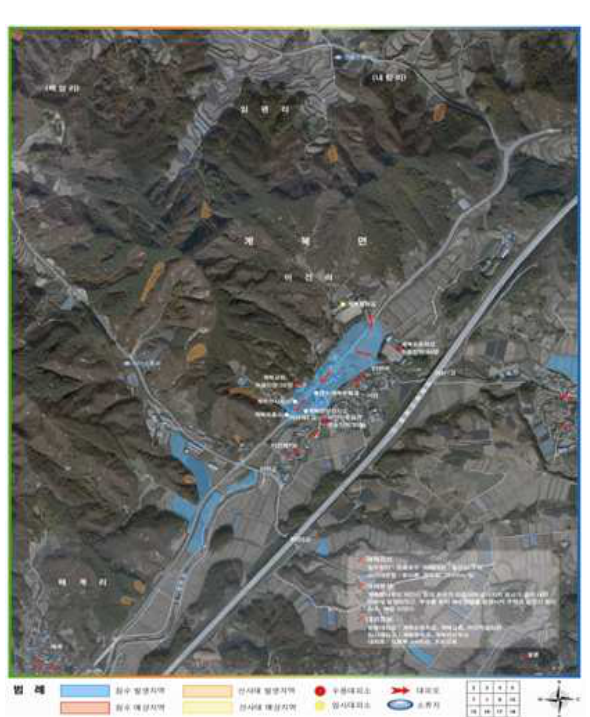
Figure 6. Disaster Prevention Map(1)